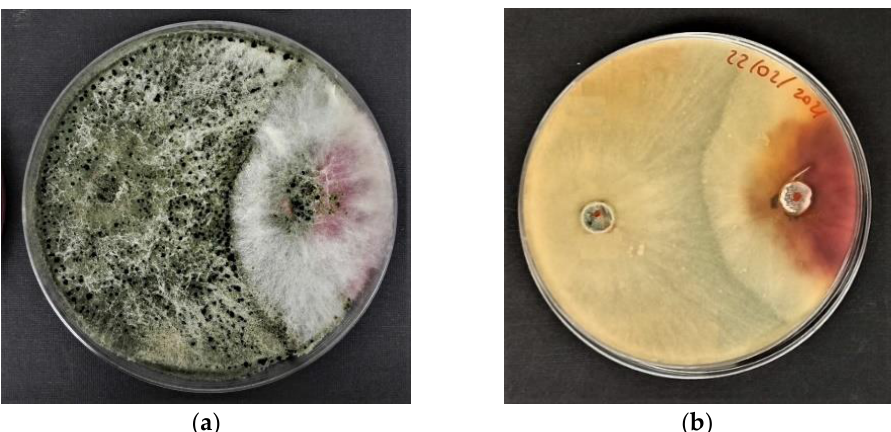
Figure 1. Front ( a ) and back ( b ) plate showing the interaction between T. harzianum T-22 (on the left) and F. culmorum (on the right) at 14 days post inoculum.